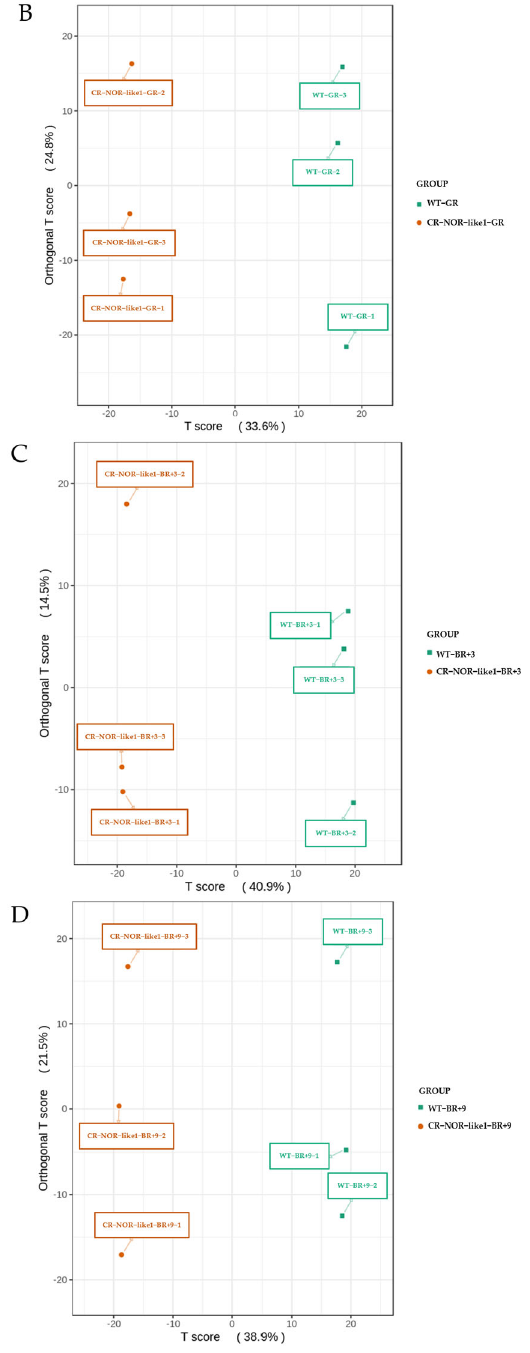
Figure 1. ( A ) PCA results of the overall sample. Each dot indicates a sample, and one color indicates the same group of samples. The closer the distribution of sample points, the more similar the types and levels of metabolites in the samples. Mix is the quality ‐ control sample. PC1, principal compo ‐ nent 1; PC2, principal component 2. Explained variants PC1: 27.41%, PC2: 16.04%. ( B ) OPLS ‐ DA model ‐ score scatterplot in GR; ( C ) OPLS ‐ DA model ‐ score scatterplot in BR+3; ( D ) OPLS ‐ DA model ‐ score scatterplot in BR+9, T score indicates the predicted principal component, and the horizontal coordinate direction shows the gap between groups. Orthogonal T score indicates the orthogonal principal component, and the vertical coordinate direction shows the gap within groups. Percentage indicates the degree of explanation of this component to the dataset.